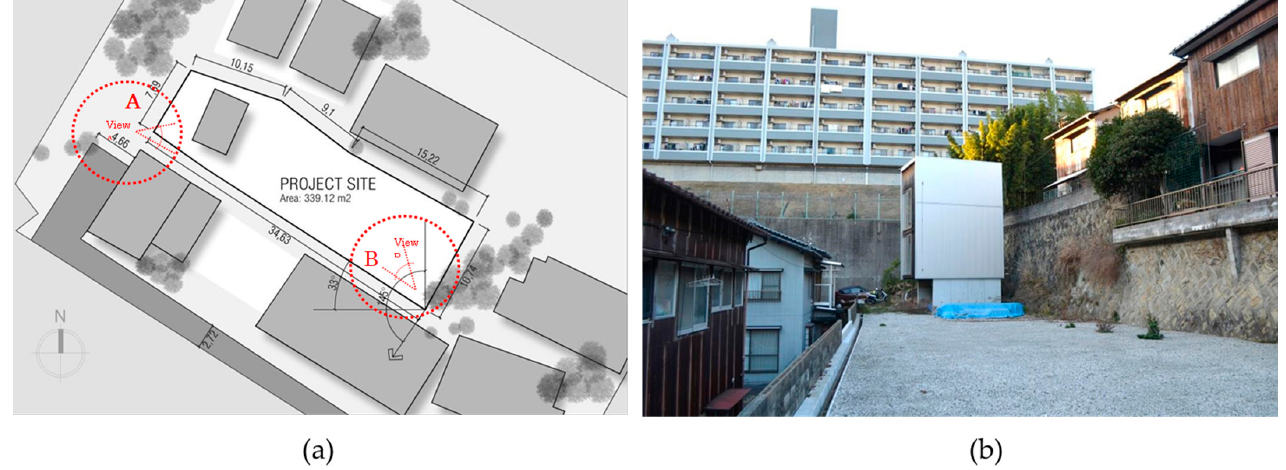
Figure 5. Site location and situation: ( a ) The site plan; ( b ) The photo of the situation in the site. Photograph by the author.